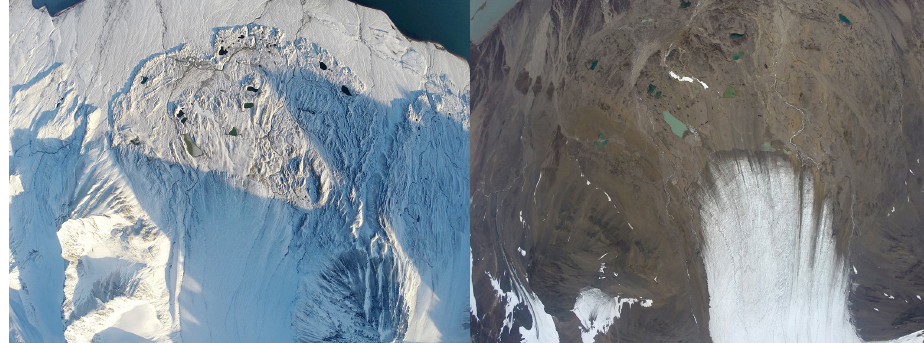
Figure 5. Sample images from our surveys (left: 2014; right: